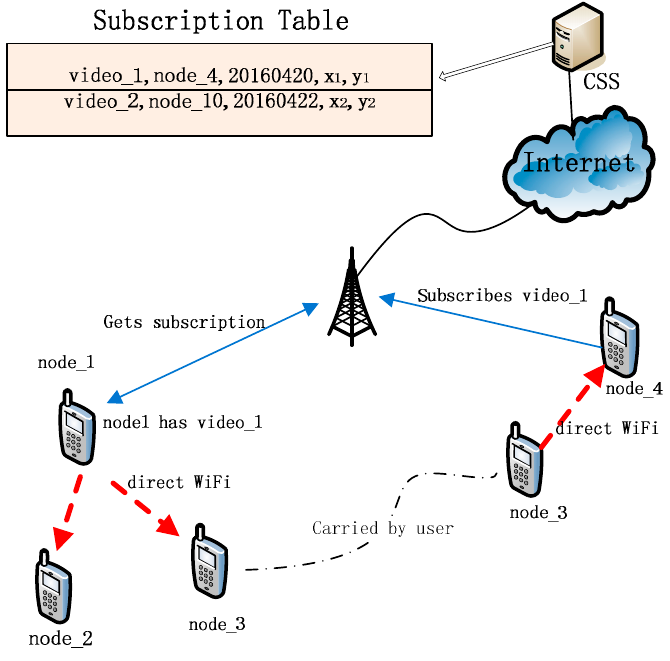
Figure 3. An example of subscribing content and opportunistic publishing content in DOPS.